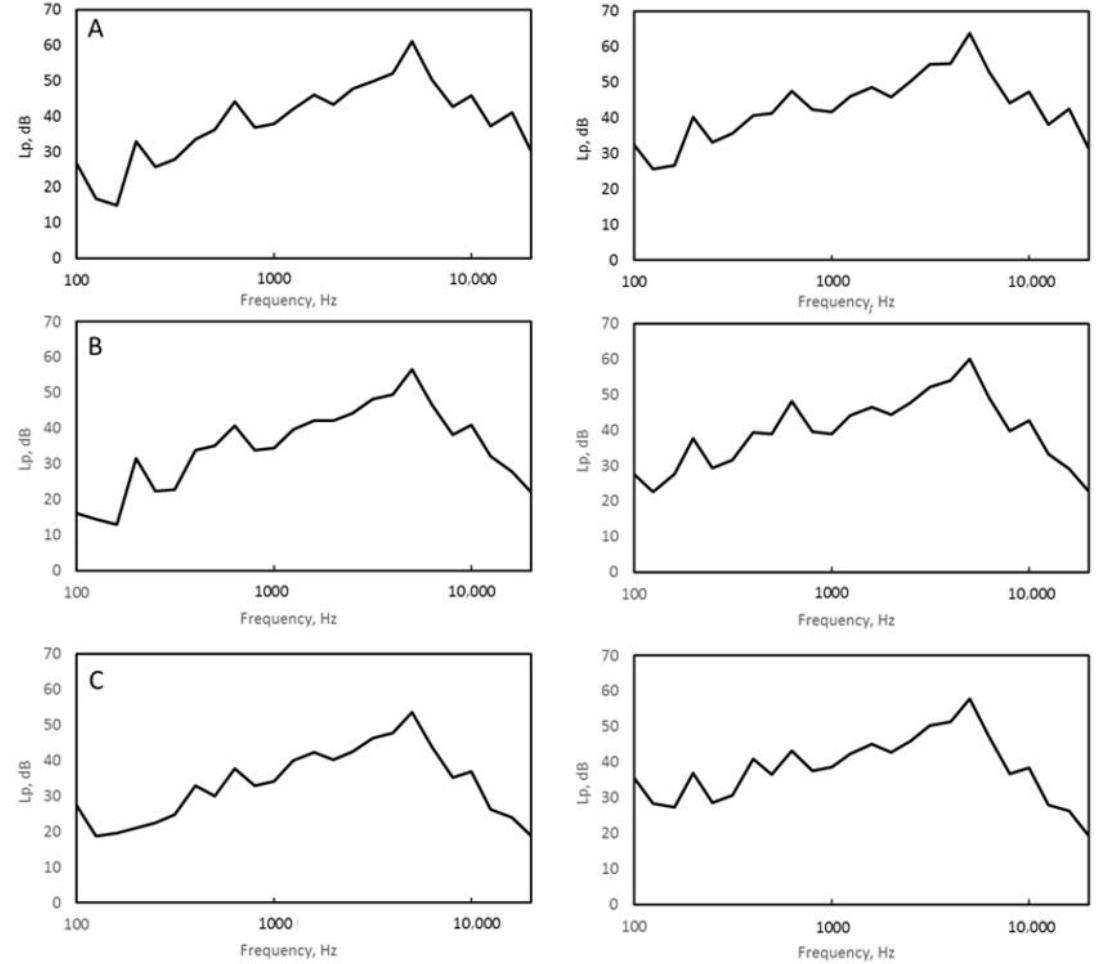
Figure 5. Values of the minimum (at the left) and average (at the right) spectrum emitted in the position of the UAV in the environment under test, with anthropic noise (voice). The receiver–source distances are respectively: (( A ) equals 5 m, ( B ) equals 10 m, and ( C ) equals 15 m).